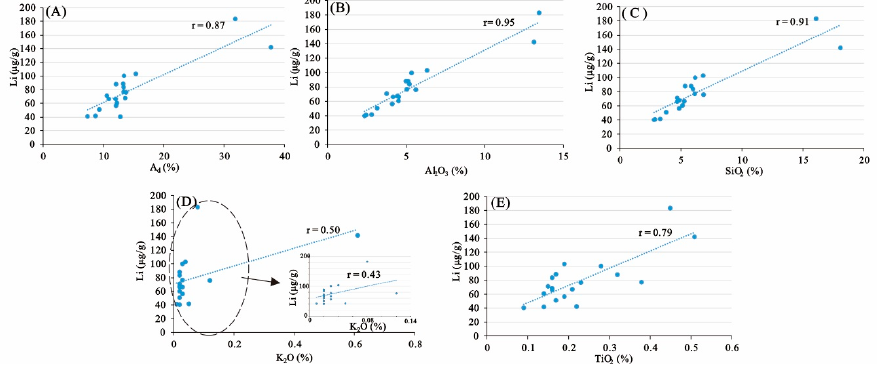
Figure 11. Relationship between Li and ash yield ( A ), Al 2 O 3 ( B ), SiO 2 ( C ), K 2 O ( D ), and TiO 2 ( E ) in coal samples.